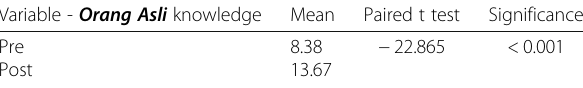
Table 2 Mean difference in the knowledge on Orang Asli Variable - Orang Asli knowledge Mean Paired t test Significance Pre Post